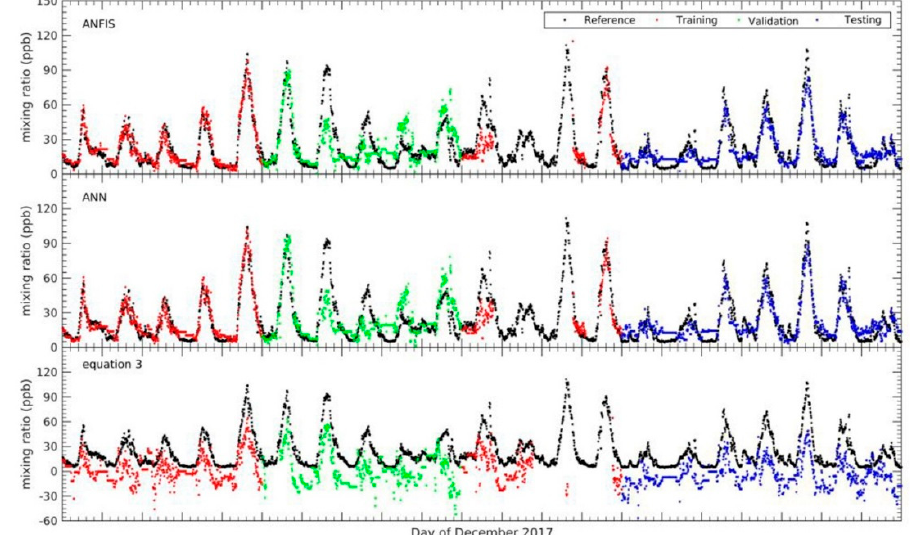
Figure 13. Comparison of O 3 values obtained from the reference instrument and the three calibration models ANFIS, ANN (MLP), and Equation (3) during the training, validation and testing.